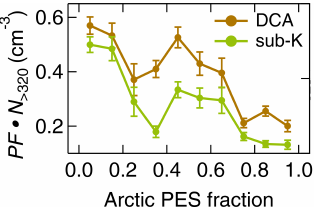
Figure 11. Scaled number concentration (PF · N > 320 ) of DCA- and sub-K-containing particles measured by the ALABAMA as a func- tion of FLEXPART-derived PES fraction over Arctic regions during the Arctic air mass period. Uncertainty analysis is given in Sect. S7.